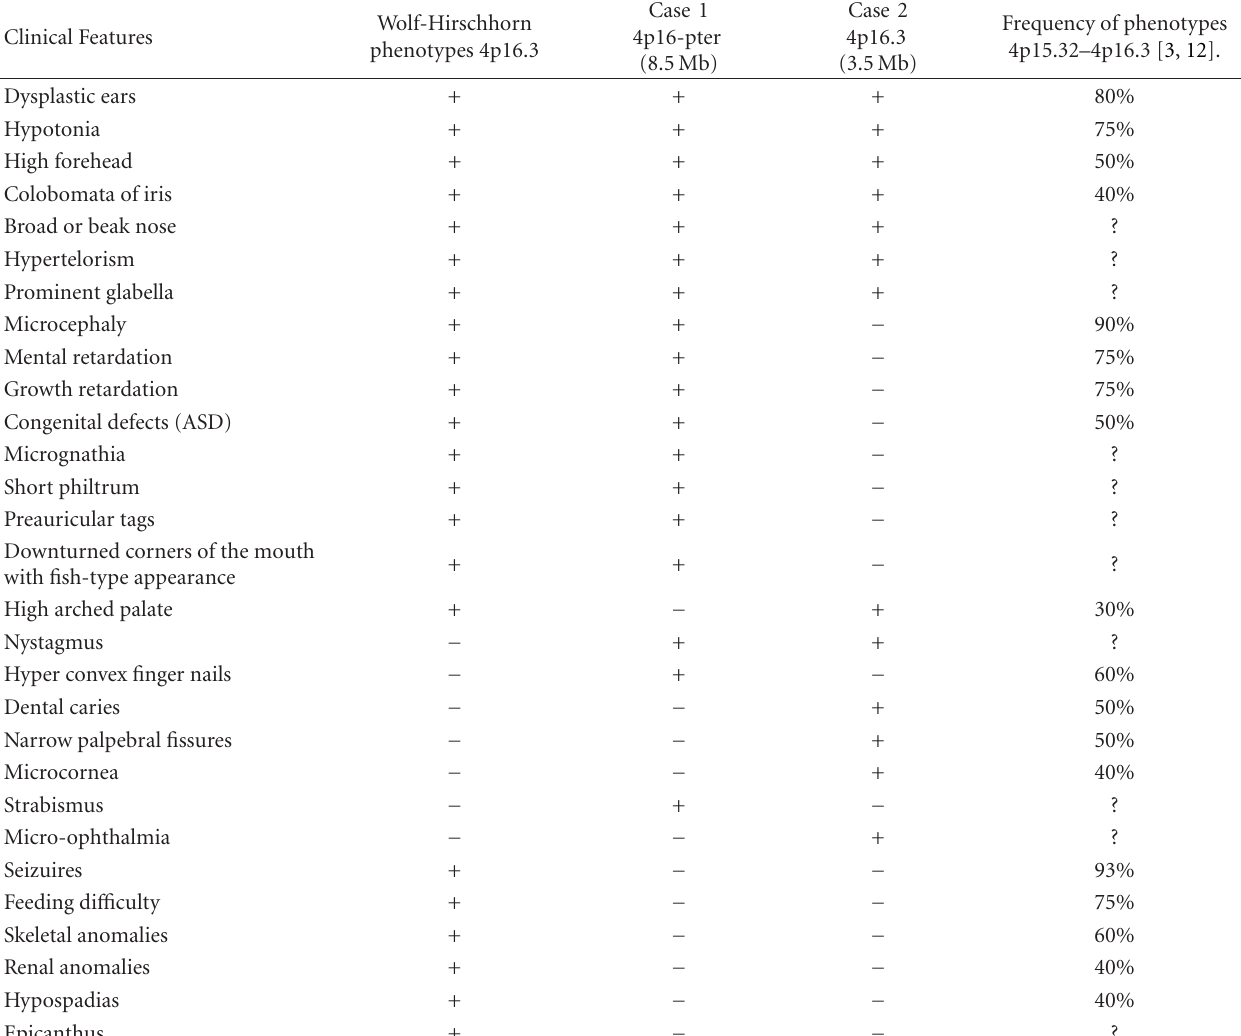
Table 1: Comparison of phenotypes in the cases and frequency of each phenotype in